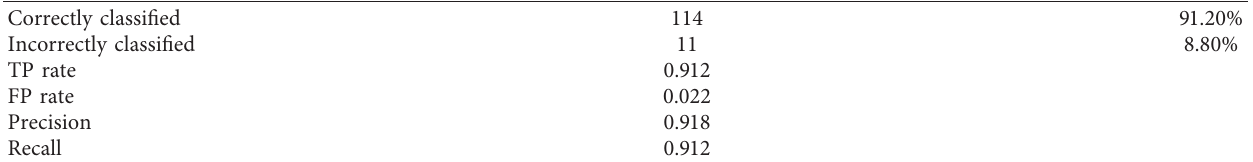
Table 13: Classification value results.